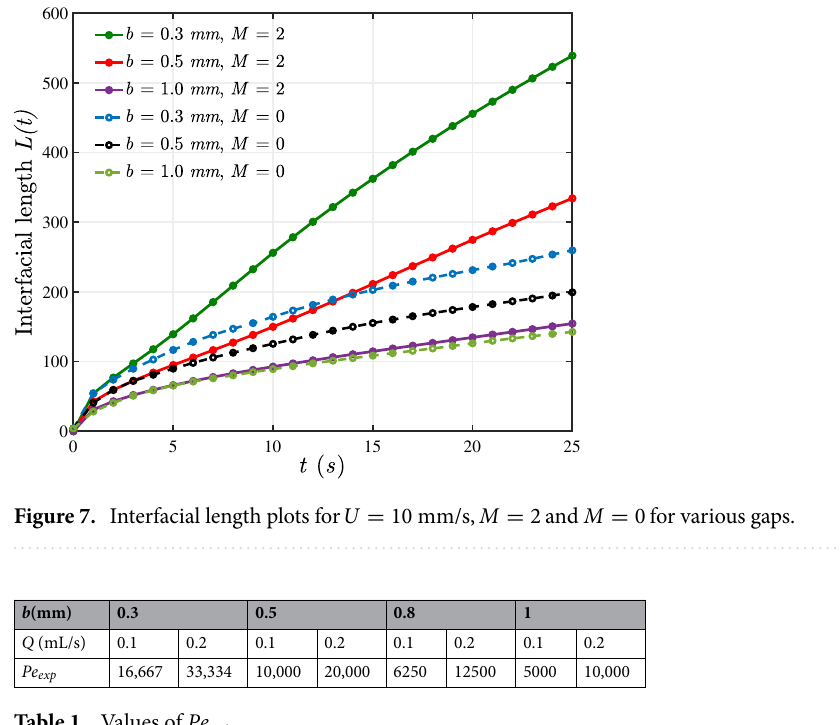
Table 1. Values of Pe exp